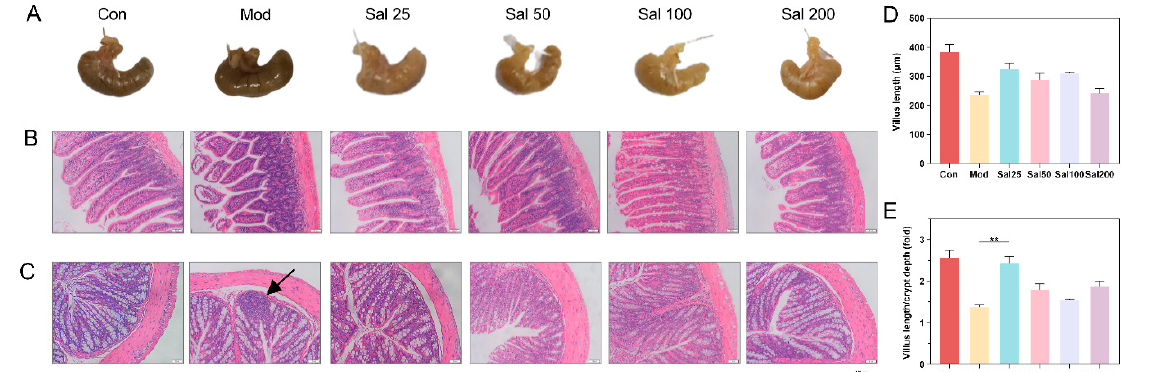
Figure 1. The effects of salidroside on mice weight ( A ), spleen index ( B ), and serum concentrations of alanine aminotransferase (ALT) ( C ), aspartate aminotransferase (AST) ( D ), IL-6 ( E ), and TNF α ( F ). The values are displayed as mean ± SEM. * p < 0.05, ** p < 0.01, *** p < 0.001.